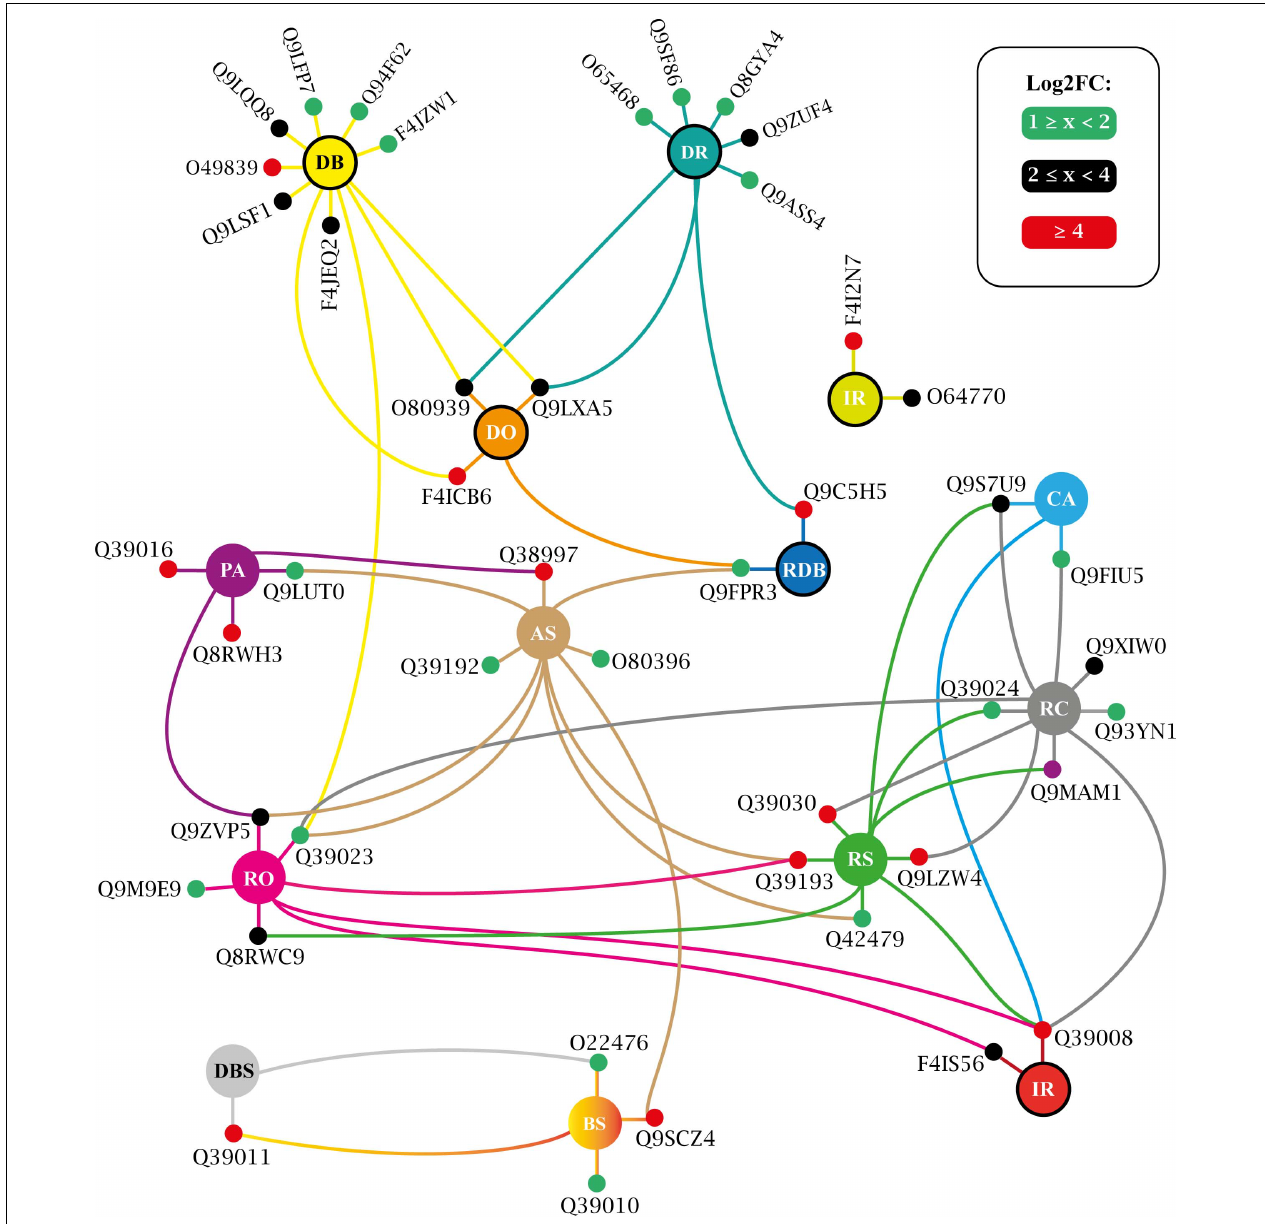
FIGURE 10 | Biological process enriched for T150 up-regulated VuPKs showing the interaction network (colored lines) of the associated elements (proteins). The colored dots (green, black, and red) in the protein Uniprot ID correspond to the fold-change log (log 2 FC) found in the present study and are according to the presented scale. The colors of the lines are associated with the colors of the central nodes that contain the abbreviation of the enriched biological process. Different colored lines connected to a given protein (colored dots—red, black, or green) indicate that this protein participates in different enriched processes. Central nodes with the border highlighted in black represent GO terms associated with the biotic stress response. T150, ‘RD150 vs. Cont.150’; GO terms enriched (AS, abscisic acid-activated signaling pathway; BS, brassinosteroid mediated signaling pathway; CA, cold acclimation; DR, defense response; DB, defense response to bacterium; DO, defense response to oomycetes; DBS, detection of brassinosteroid stimulus; IR, innate immune response; PA, positive regulation of abscisic acid-activated signaling pathway; RDB, regulation of defense response to bacterium; RC, response to cold; RO, response to osmotic stress; RS, response to salt stress; RD, root dehydration; Cont., control). Adapted from NeVOmics tool